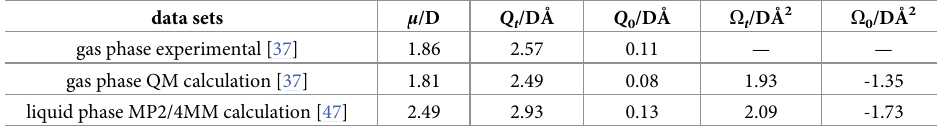
Table 1. Reference multipole moments of single water